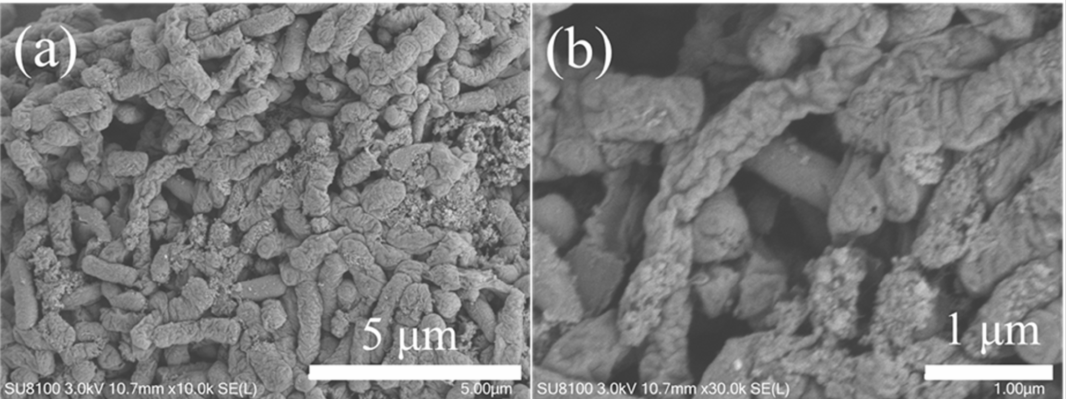
Figure 5. Scanning electron microscope (SEM) images of B. subtilis after PA-AEW treatment. ( a ) Scale bar: 5 µ m, ( b ) scale bar: 1 µ m.